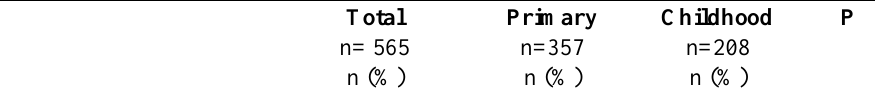
Descriptive data of students in Primary and Childhood Education